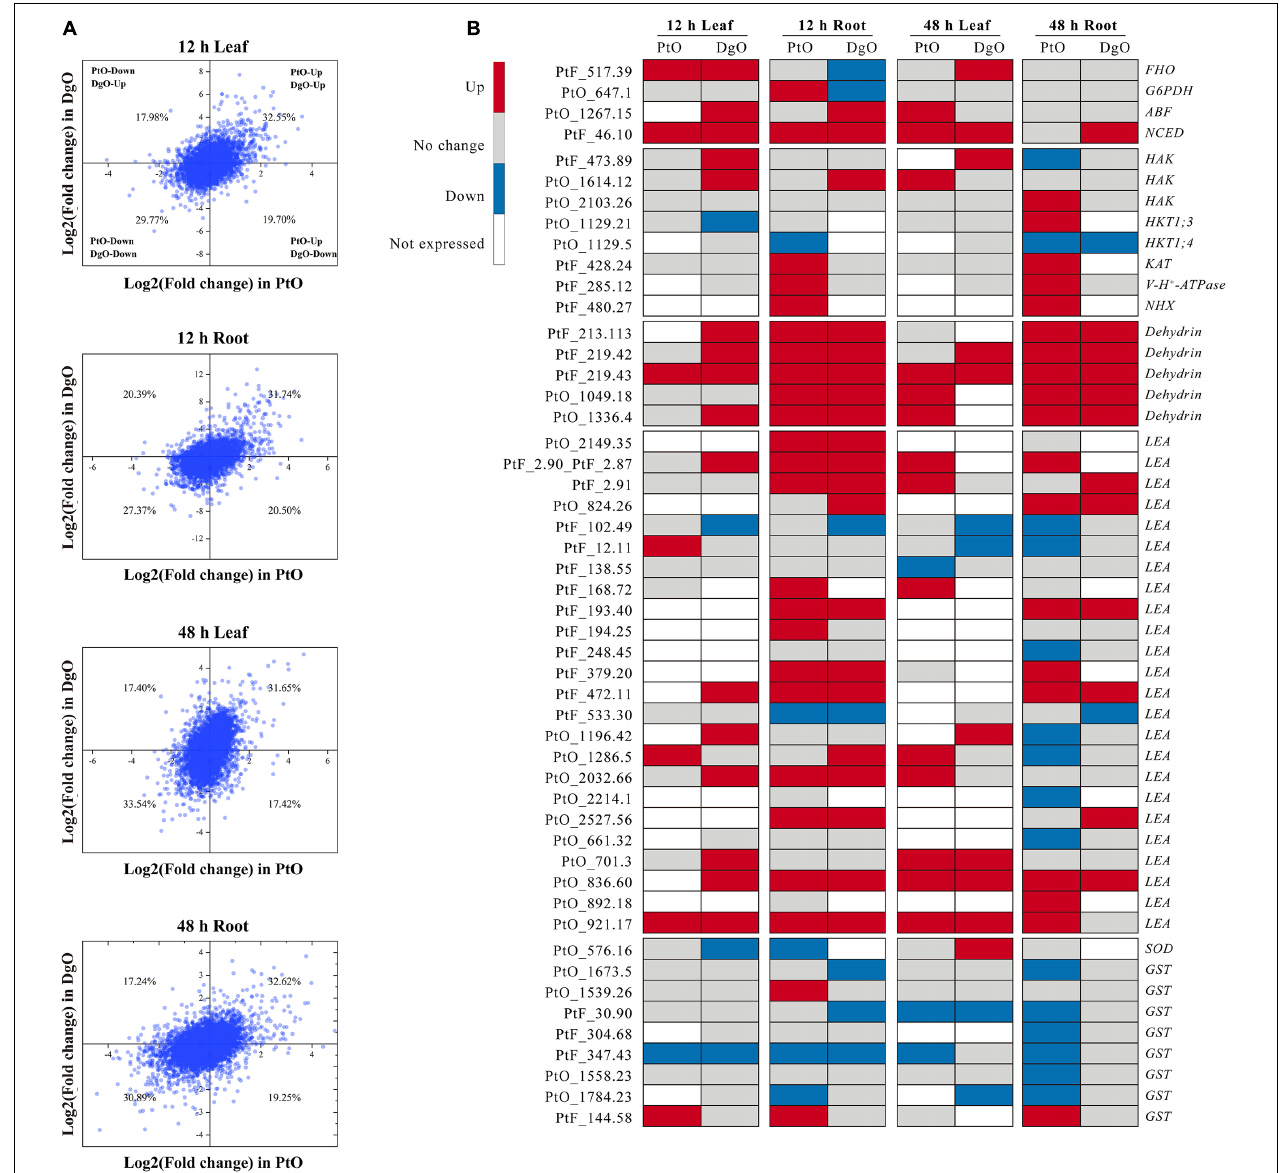
FIGURE 6 | Comparative orthologous expression response of P. tenuiflora and D. glomerata to salinity stress. (A) Rectangular coordinate system with x = log 2 [fold change (stress/control) of PtO] and y = log 2 (fold change of DgO) for general genes. (B) Heat map showing the expression response of the P. tenuiflora ortholog (PtO) and D. glomerata ortholog (DgO) to salinity stress for each salinity tolerance gene. The 15-day-old seedlings were exposed to 300 mM NaCl for 12 and 48 h. Each treatment had three biological replicates. FHO, flavonoid 3 (cid:48) ,5 (cid:48) -hydroxylase; G6PDH, glucose-6-phosphate dehydrogenase; ABF, ABA responsive element binding protein; NCED, 9- cis -epoxycarotenoid dioxygenase; HAK, KUP/HAK/KT K + transporter; HKT, high-affinity K + transporter; KAT, potassium channel KAT; LEA, late embryogenesis abundant protein; NHX, Na + /H + exchanger; SOD, superoxide dismutase; GST, glutathione S